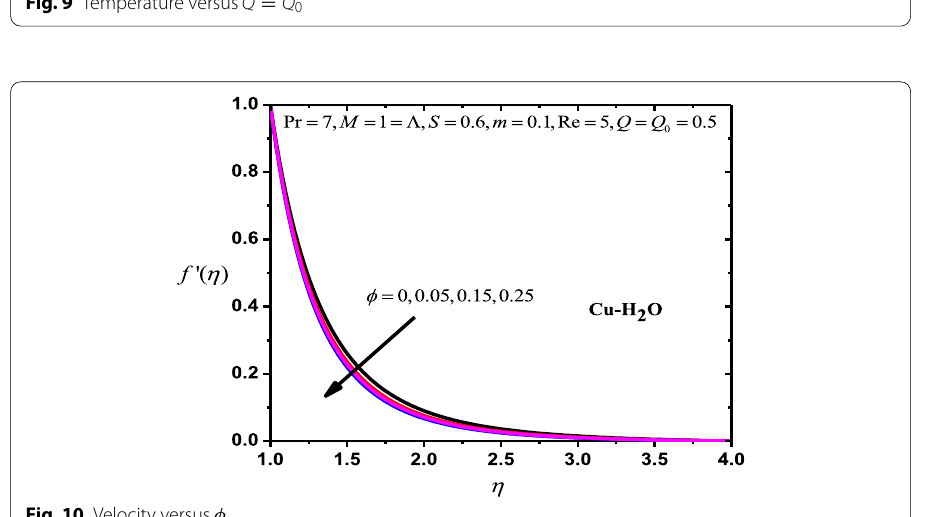
Fig. 9 Temperature versus Q